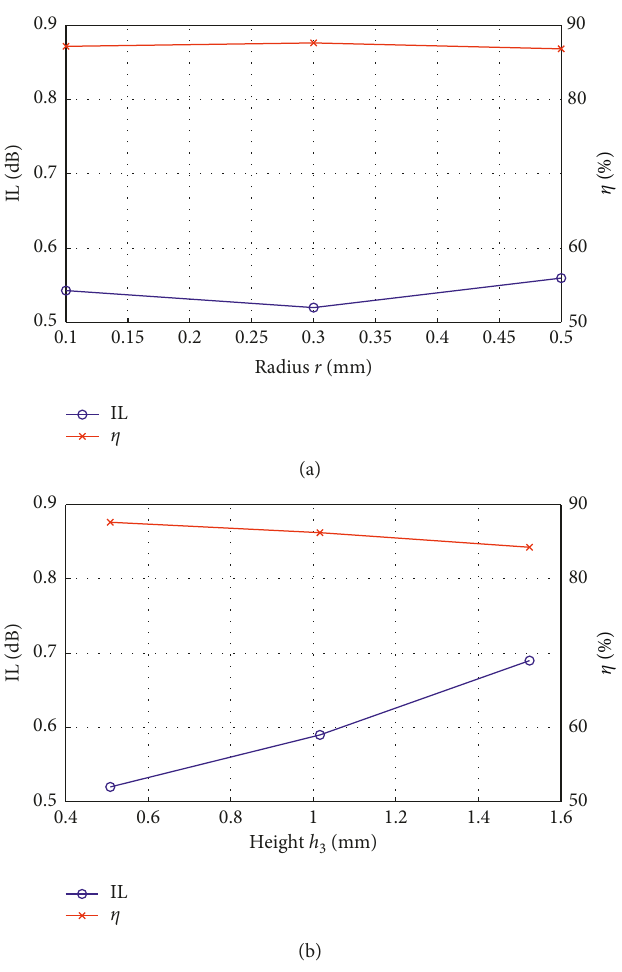
Figure 8: Simulated insertion loss and estimated overall conversion efficiency of the 8 × 8 combining network at 2.45GHz as a function of (a) via radius r and (b) via length h 3 .